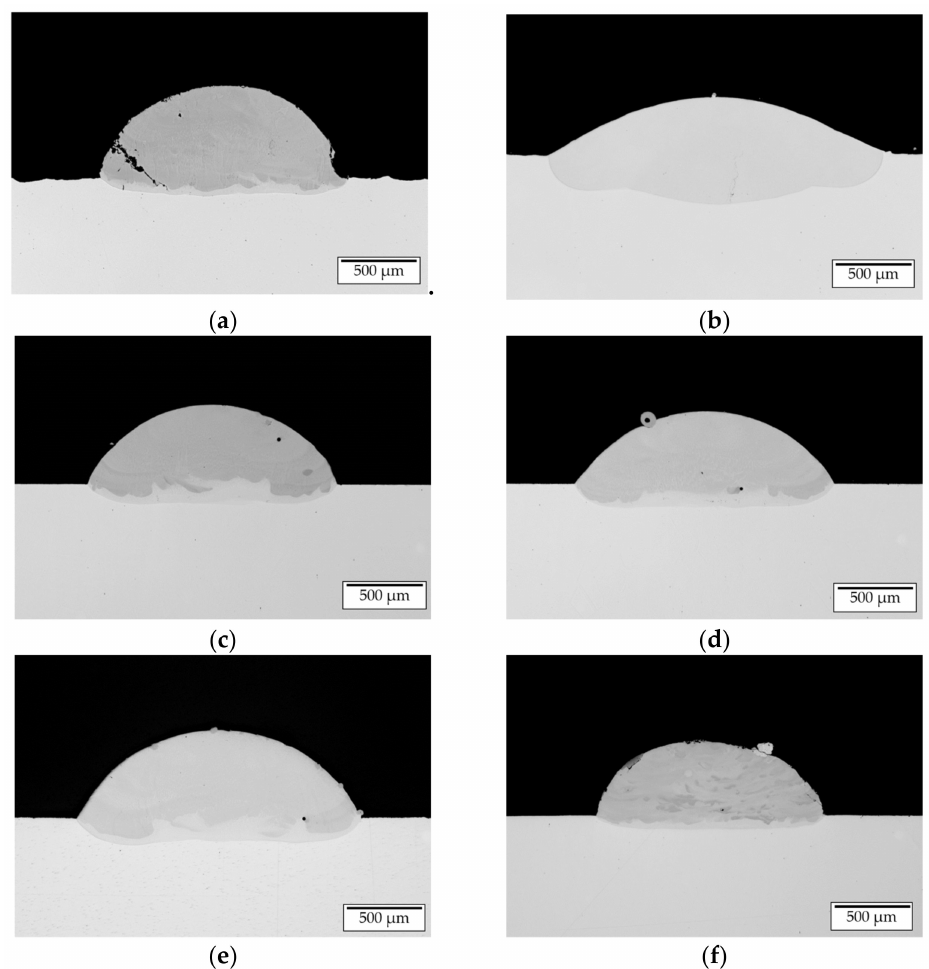
Figure 9. LOM images of cross sections of manufactured single tracks ( a )—set 1, ( b )—set 2, ( c )—set 3, ( d )—set 4, ( e )—set 5, ( f )—set